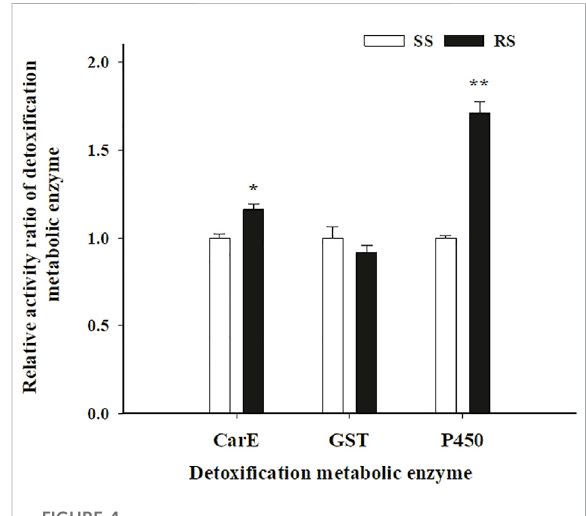
FIGURE 4 Means (±SE) of activity ratio of detoxi fi cation metabolic enzyme in SS and RS strains of SBPH. *Signi fi cant at 0.05 level and **Signi fi cant at 0.01 level using the Tukey ’ s test.